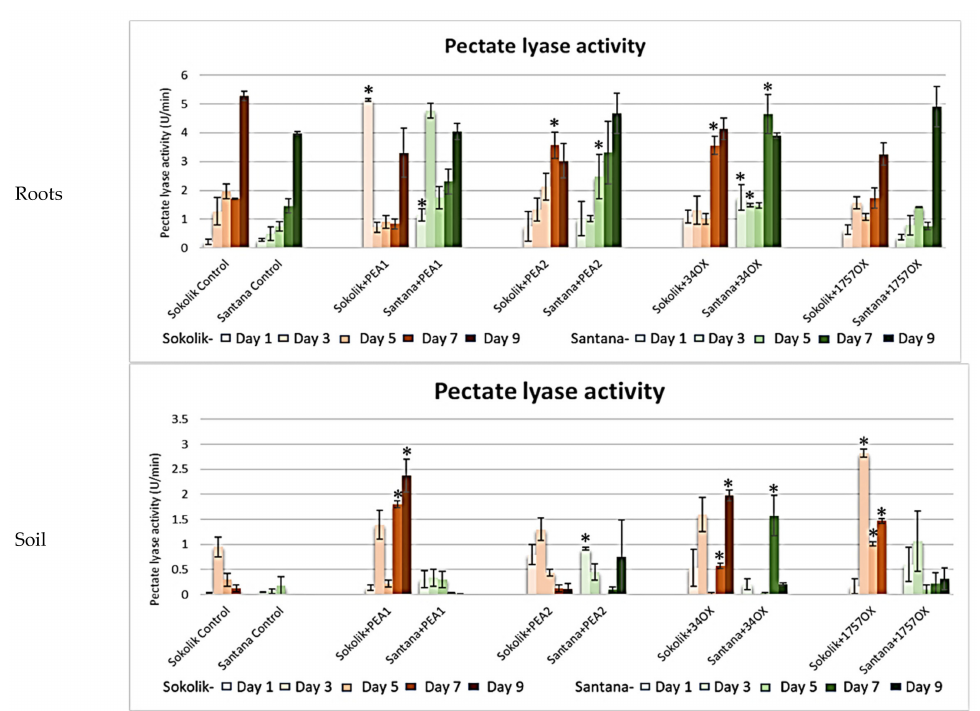
Figure 7. Pectate lyase activity (micromoles of galacturonic acid produced per minute (U/min)) obtained from the roots and soil of Sokolik and Santana infected with PEA1, PEA2, 34OX and 1757OX and the control (calculated from triplicate treatments). Error bar represents the standard error. * Statistically significant ( p <